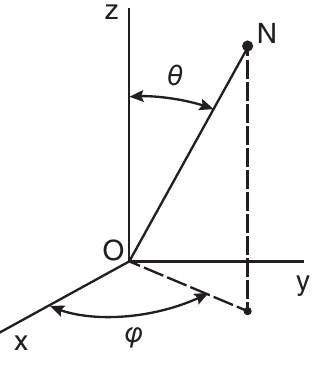
Figure 9. Geometry of spheroid orientation. Adopted from Ma- trosov (1991a). In the case of ψ = 0 ◦ , x , y , and z correspond to e x , e y , and e z , respectively. ON is the symmetry axis of the spheroid.